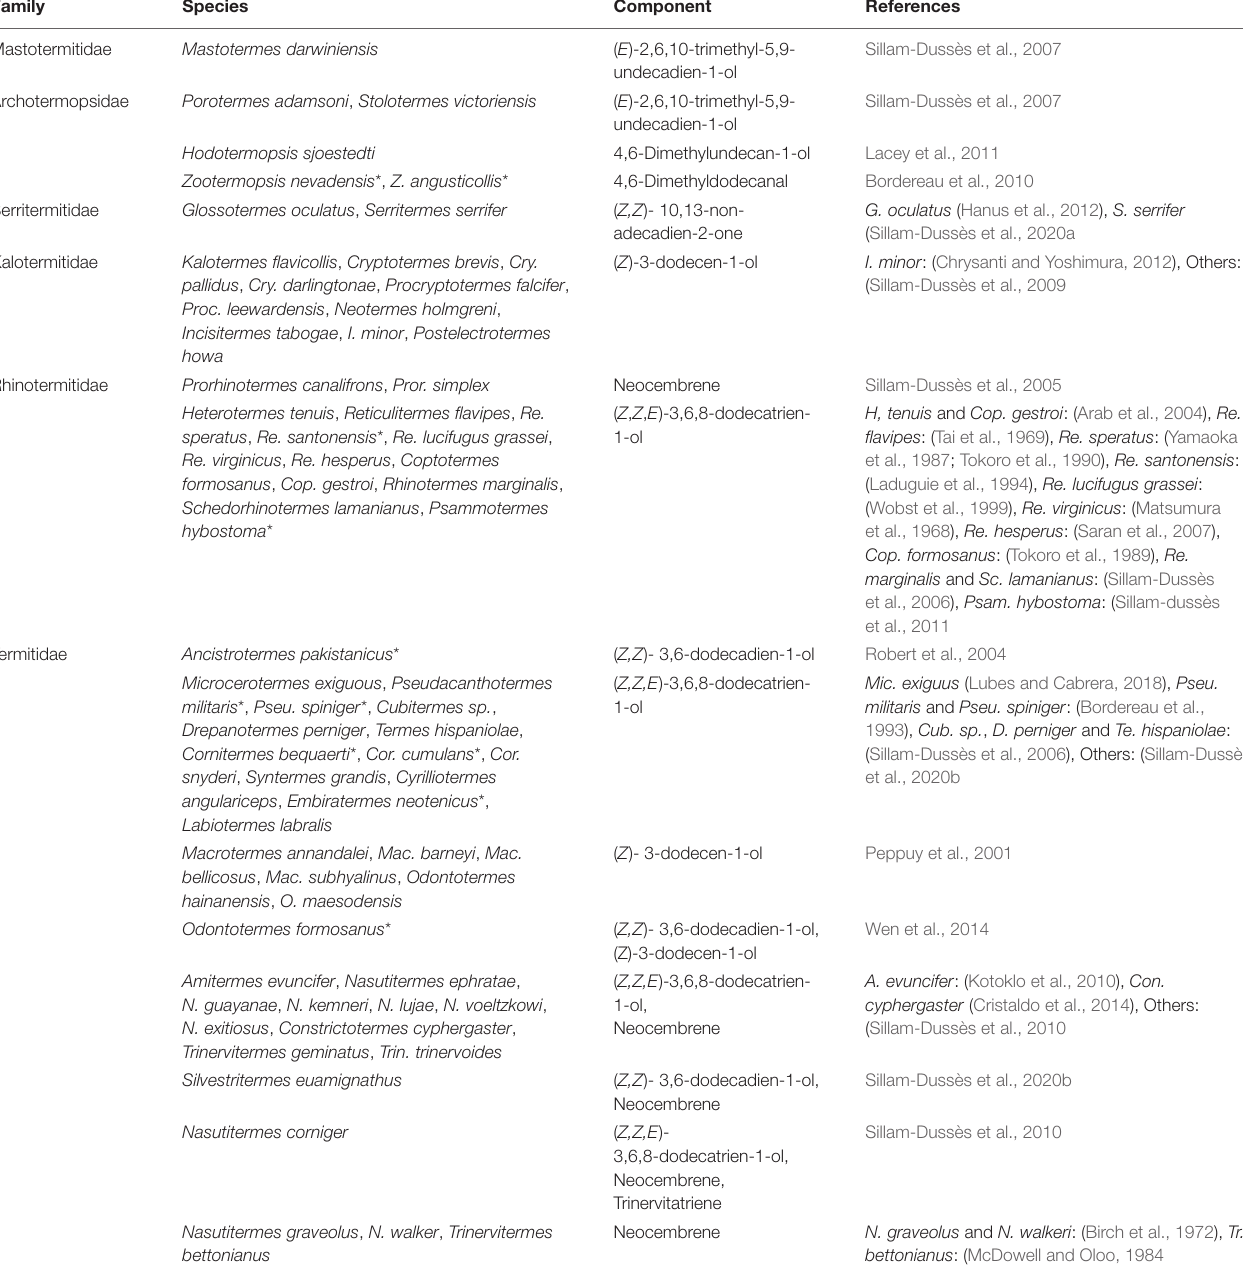
TABLE 2 | List of trail-following pheromones in termites. Family Species